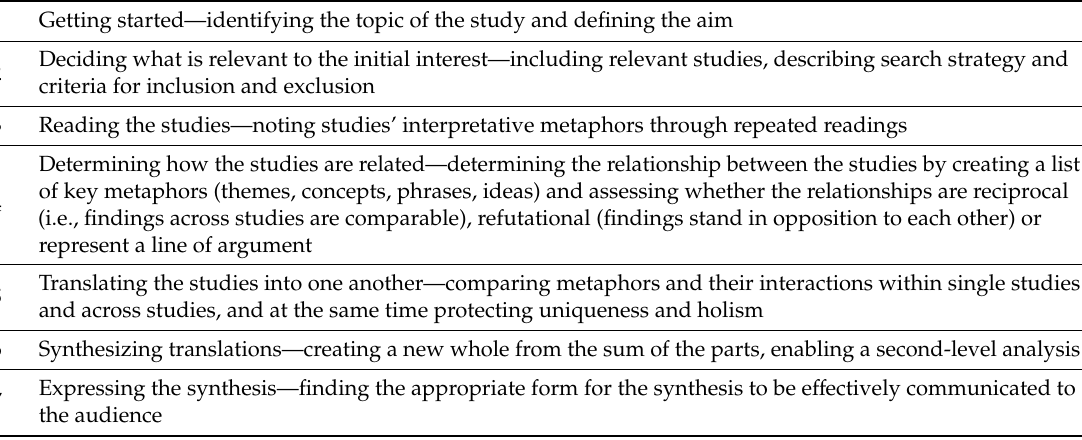
Table 1. Steps in